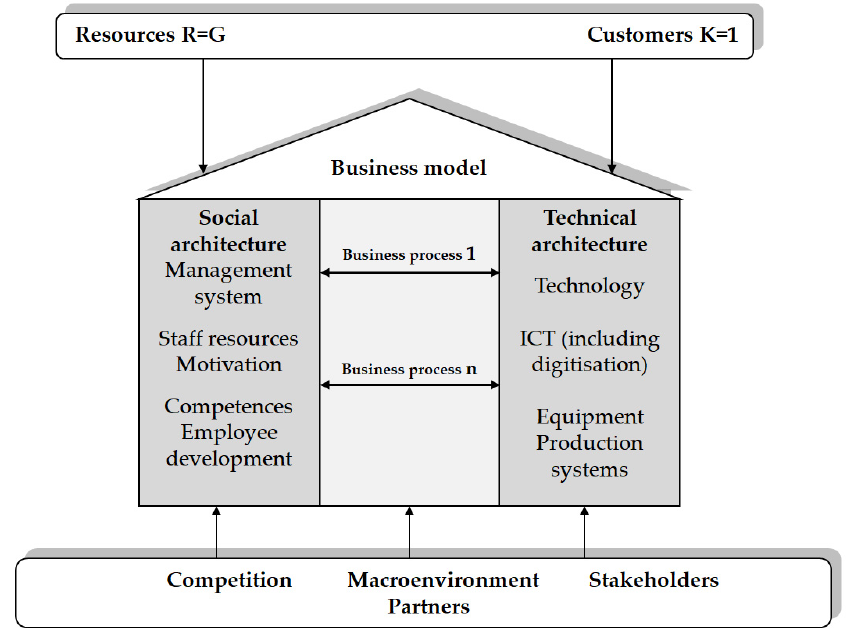
Figure 1. Business model concept according to the principles of the New Era of Innovation. Table 1. Properties of changes that energy undertakings will